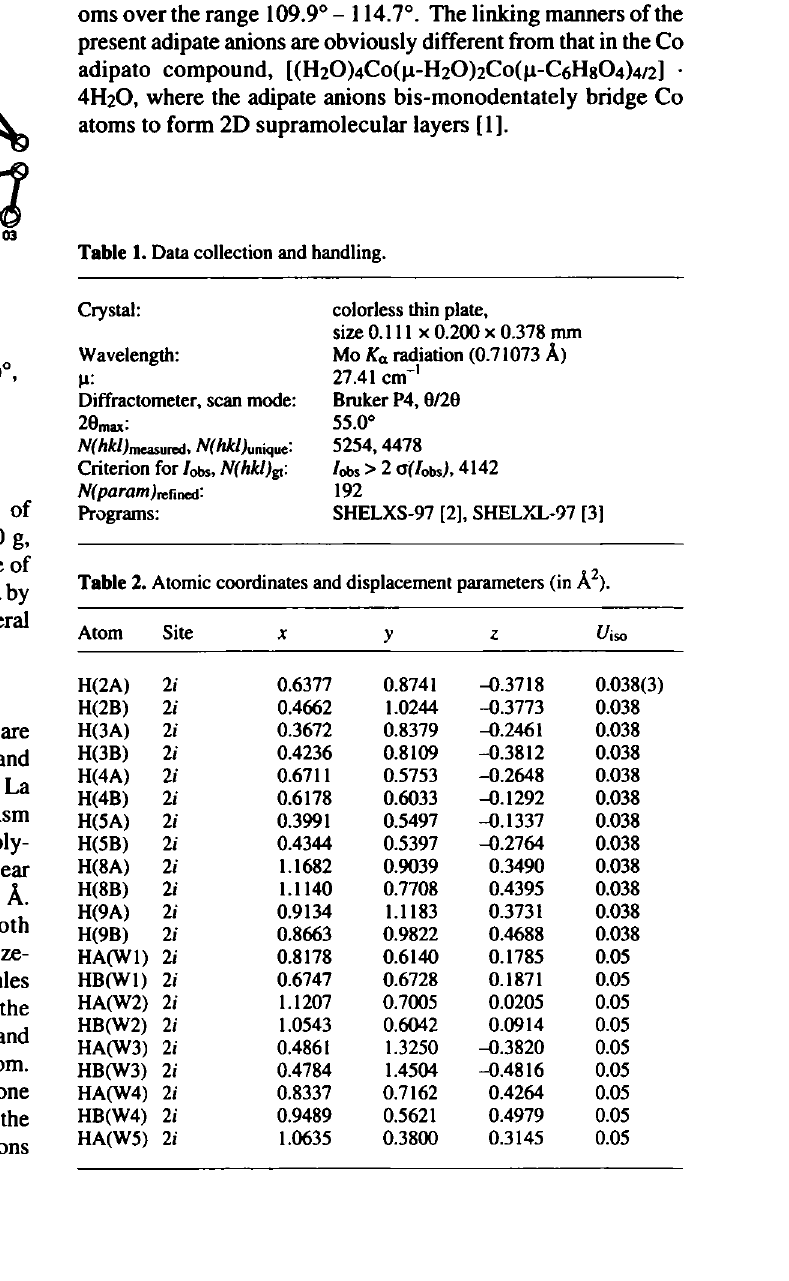
Table 1. Data collection and handling.